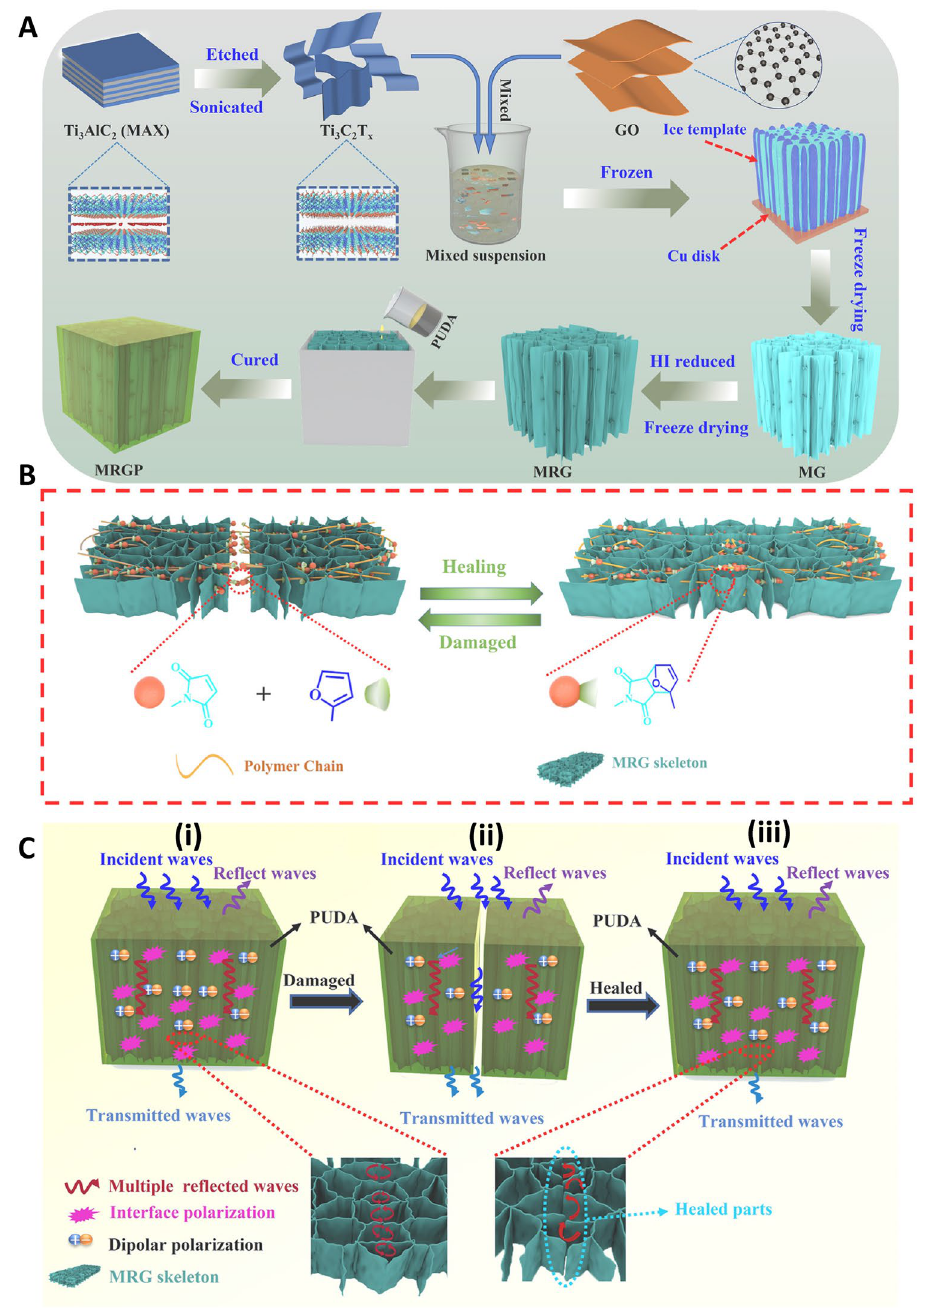
Fig. 6 A Preparative process of MXene/rGO oxide/polyurethane (MRGP) composites. B Mechanism of heat-stimulated healing procedures in MRGP composites. C EMI shielding mechanisms of original ( i ) severed, ( ii) healed, and ( iii) MRGP composite skeleton. PUDA: polyurethane containing Diels–Alder bonds; MRG: MXene/rGO hybrid aerogel. Reproduced with permission from Ref. [72]. Copyright 2022